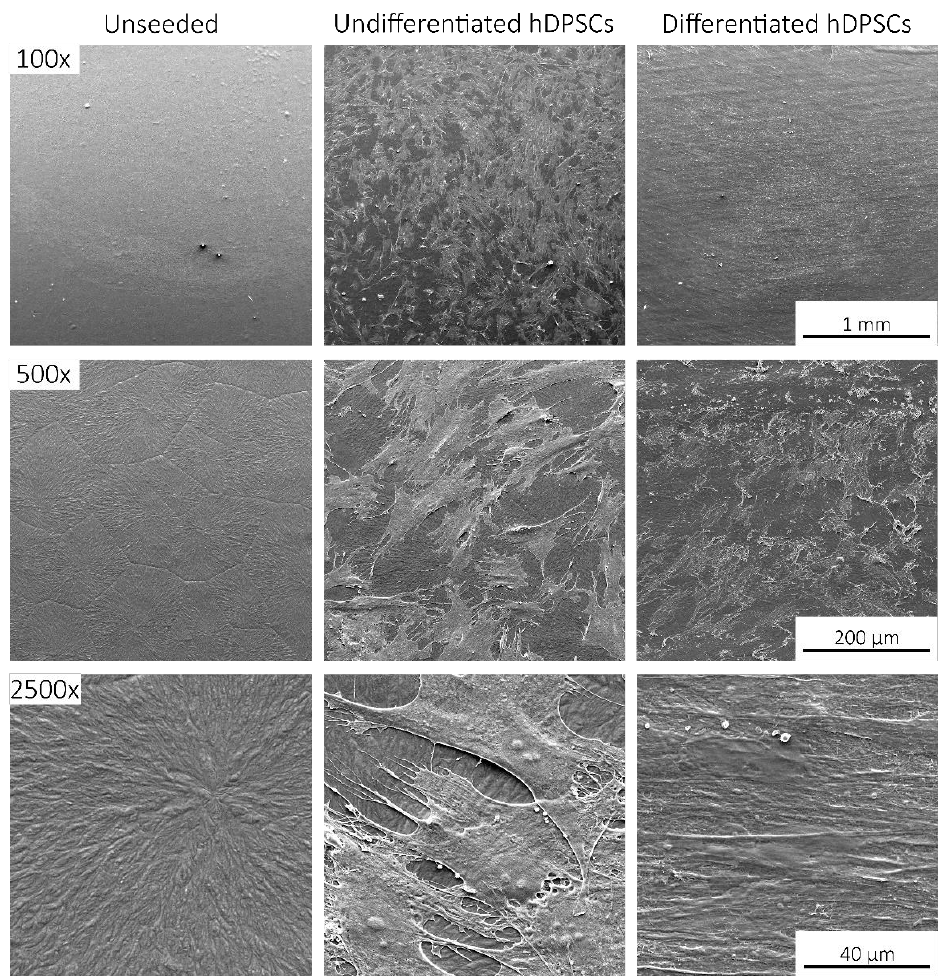
Figure 5. SEM images for the SS/SIL/PLLA group. Upper panel 100× magnification, middle panel 500× magnification, and lower panel 2500× magnification. First column: Unseeded devices; middle column: Seeded undifferentiated hDPSCs devices; third column: Seeded differentiated hDPSCs devices.